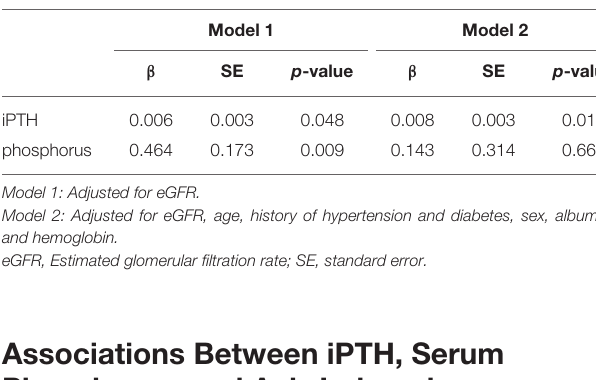
eGFR, Estimated glomerular filtration rate.